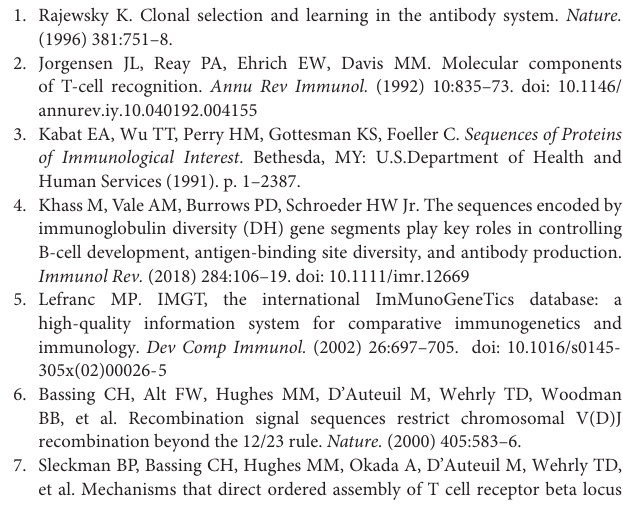
FIGURE S1 | Creation of the D β YTL targeting construct. FIGURE S2 | Flow scheme for analysis and sorting of T cell subsets in the D altered and WT mice. DN thymocytes gated on live, lineage negative (CD3, CD4,